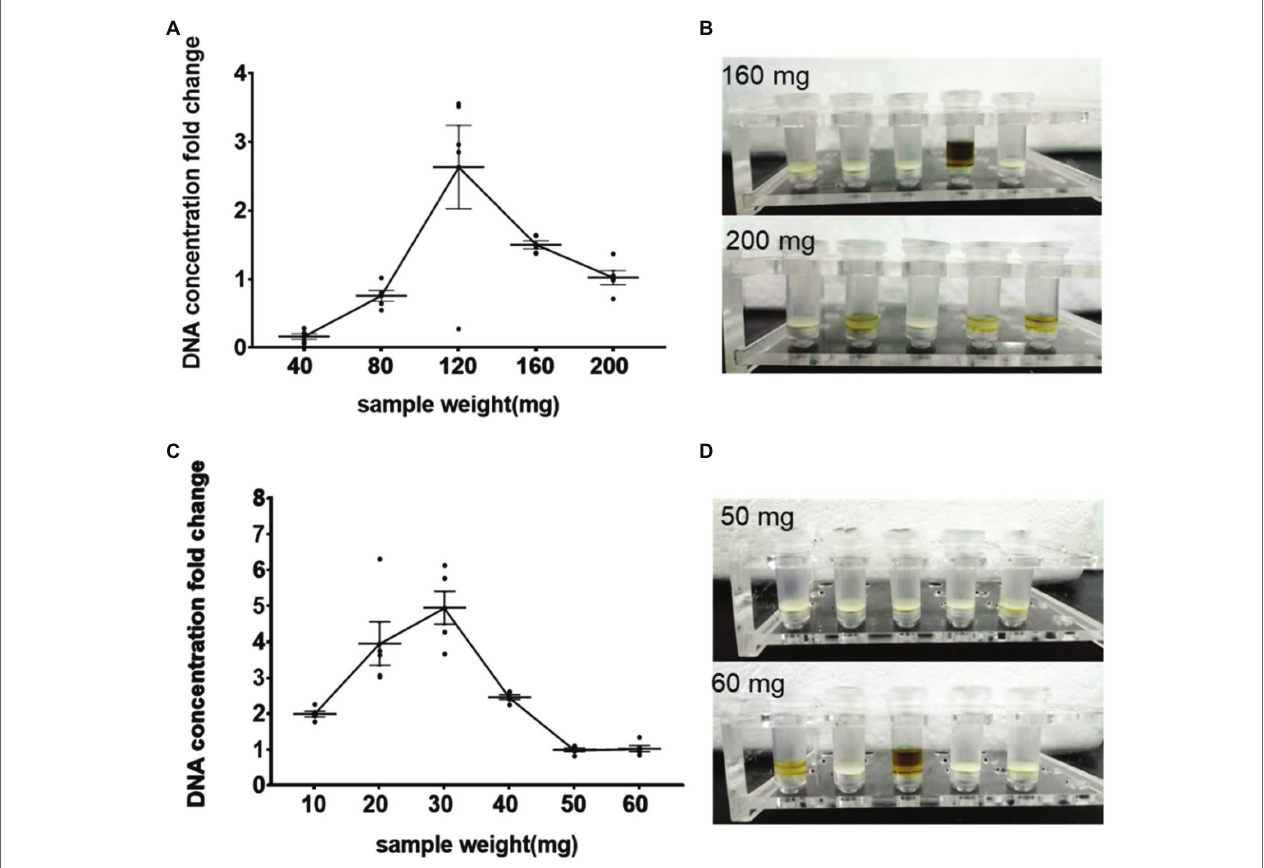
FIGURE 1 | Effects of meconium status and loading amount on DNA extraction efficiency. (A) DNA concentration (fold change) vs. fresh meconium loading amount (mg); (B) Columns could be blocked by overloaded fresh samples (loading with 160 and 200 mg after centrifugation); (C) DNA concentration (fold change) vs. freeze-dried meconium loading amount (mg); (D) Columns could be blocked by overloaded freeze-dried samples (loading with 50 mg and 60 mg after centrifugation). The results are presented as the average of five duplicates ± SEM. The corresponding data were shown in Supplementary Table S2